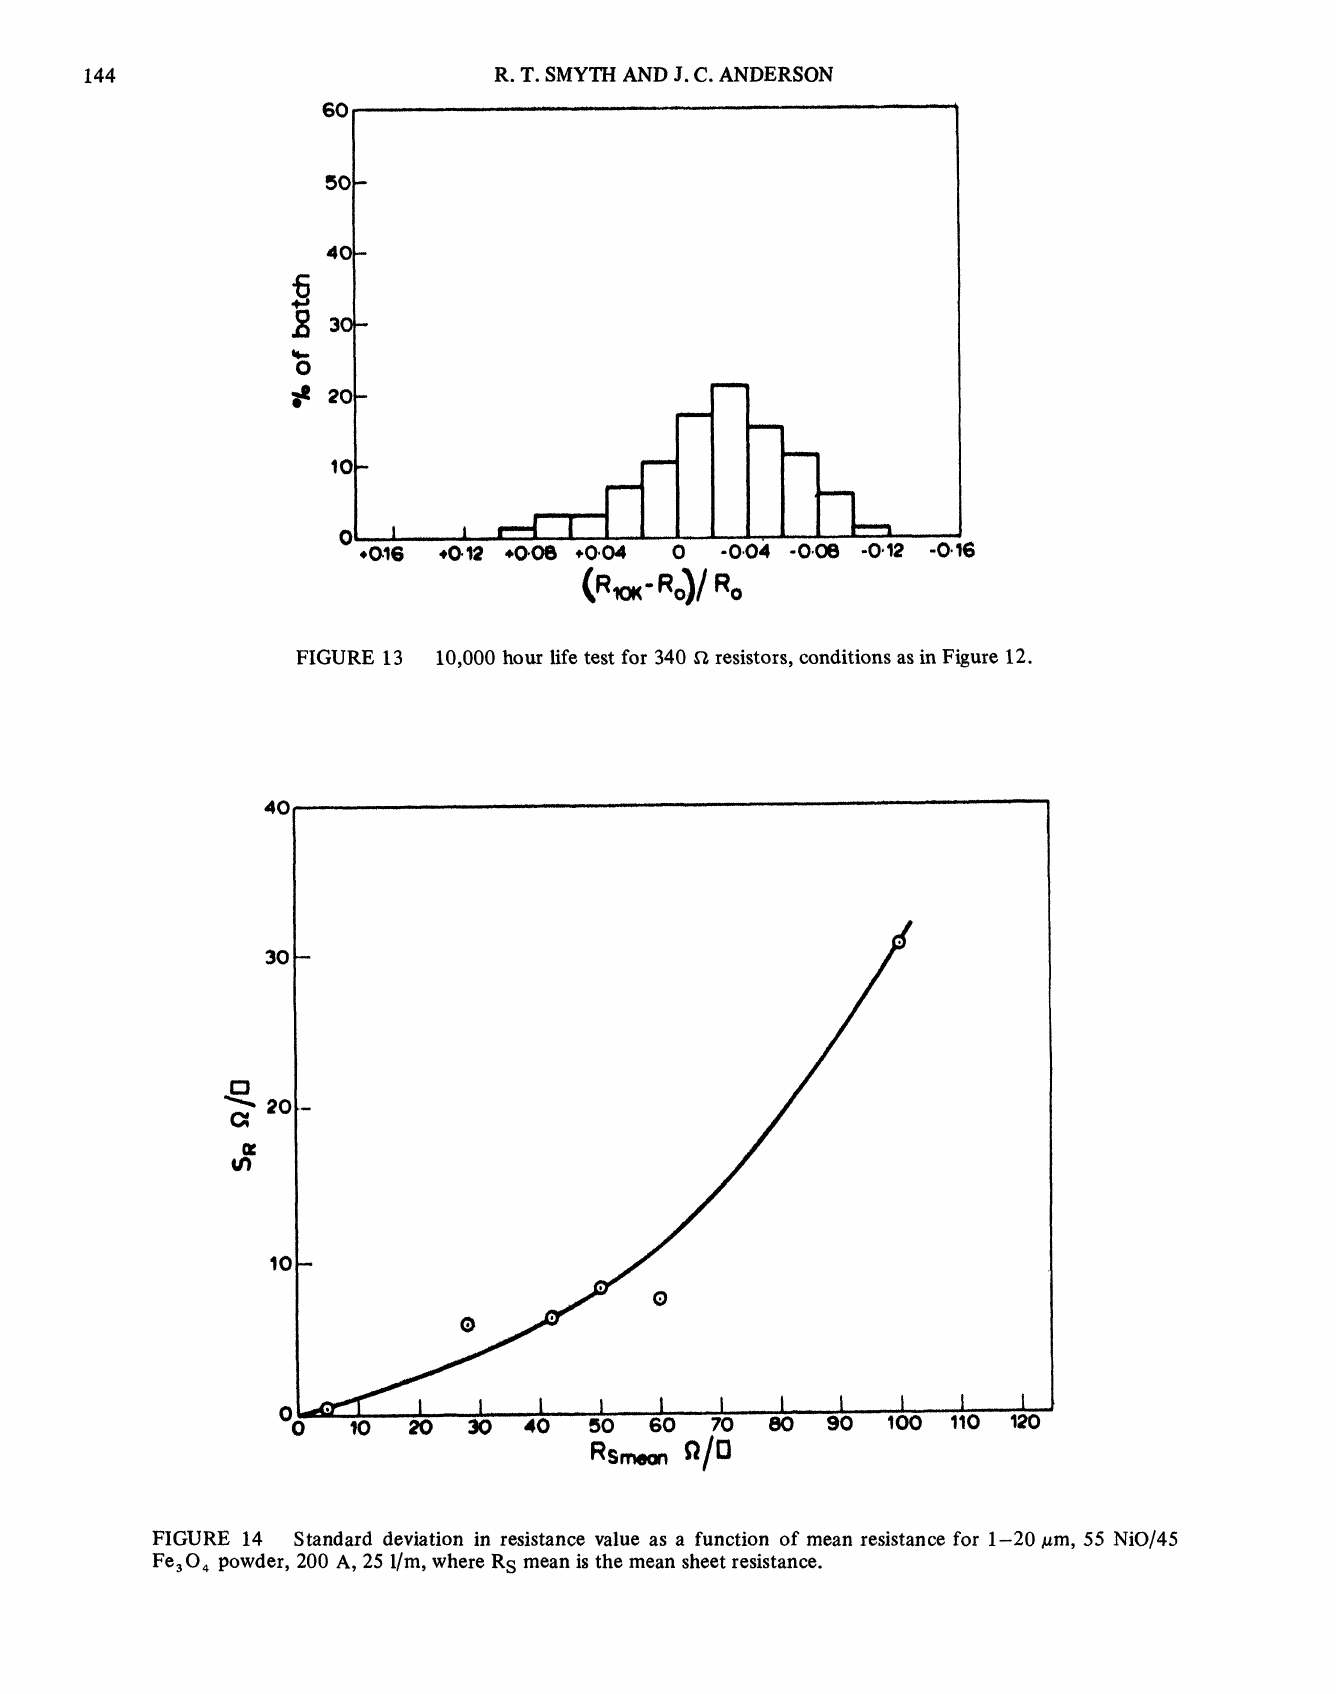
FIGURE 14 Standard deviation in resistance value as a function of mean resistance for 1-20 m, 55 NIO/45 Fe O powder, 200 A, 25 l/m, where R S mean is the mean sheet